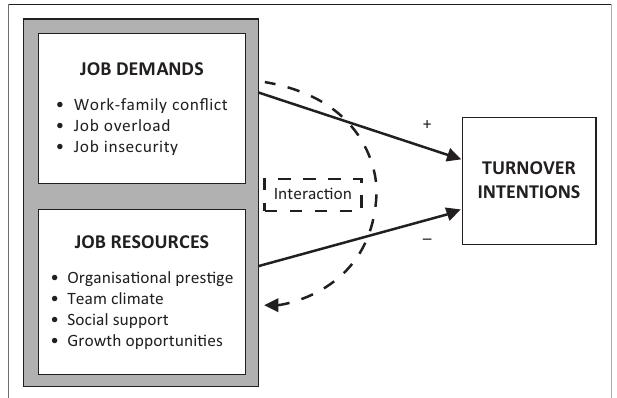
Source : Adapted from Procopiou Ribeiro, S. (2012). The retention of South African female chartered accountants in public practice . Unpublished master’s dissertation, University of Johannesburg, South Africa FIGURE 1: Theoretical model on the impact of job demands and resources on turnover intentions of women chartered